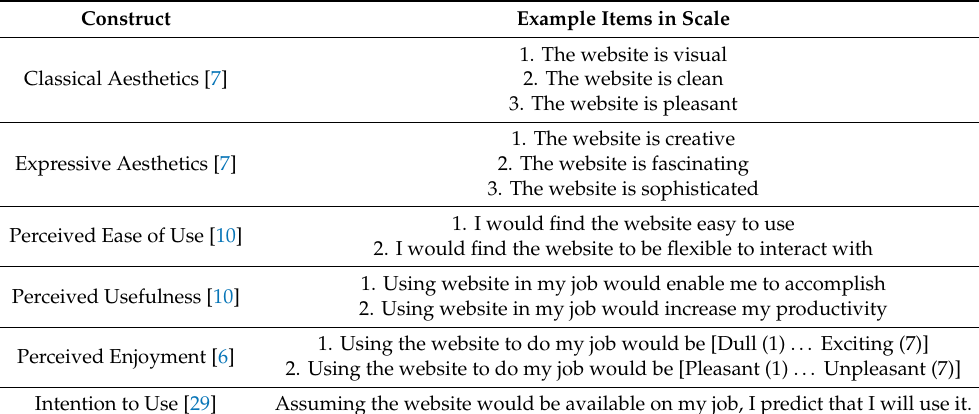
Table 2. Study’s constructs and indicators.